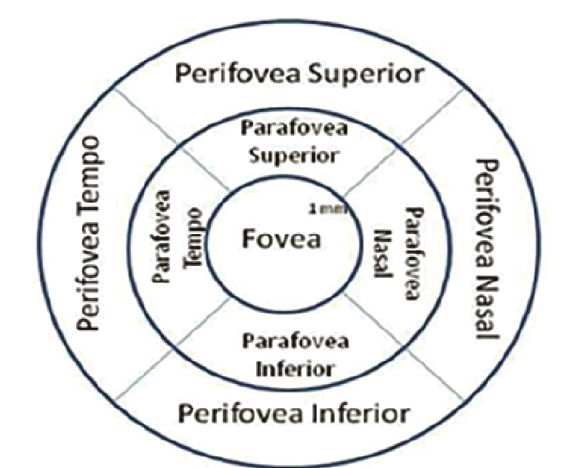
Figure 2. The nine zones of the Optovue RTVue spectral-domain ocular coherence tomography (SD-OCT) retinal map defined by standard the Early Treatment Diabetic Retinopathy Study (ETDRS)